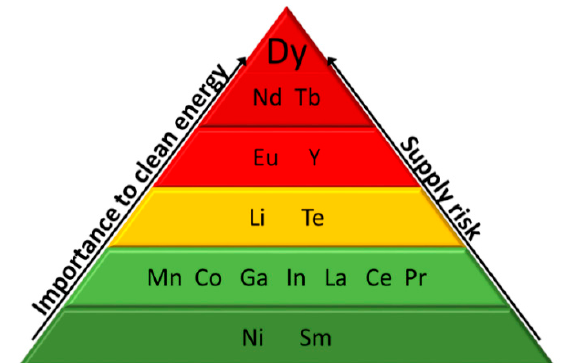
Figure 3. Criticality assessment of rare earth elements (REEs) and other elements in the medium term (2015–2025). It is represented in green the elements that are not critical, in yellow the near-critical elements and in red the critical elements.